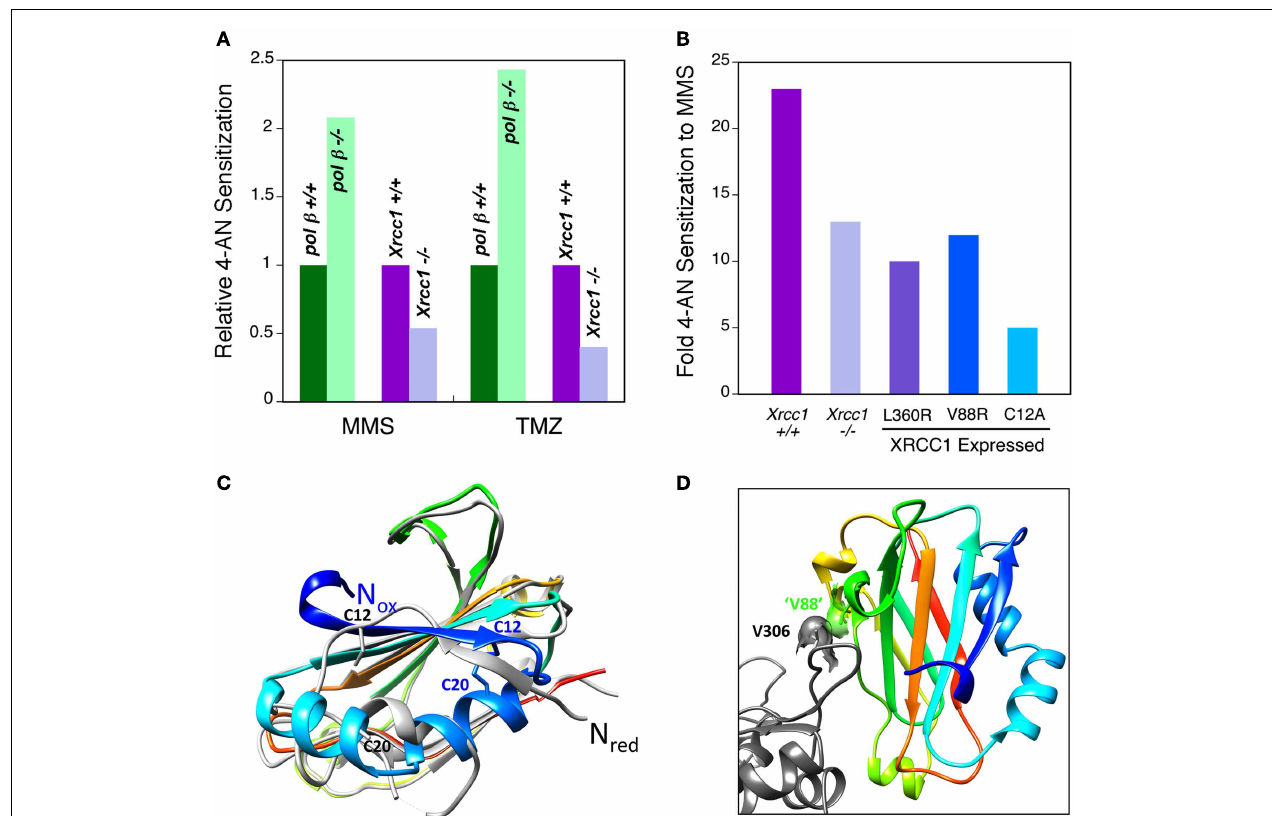
amino-termini are on opposite sides of this domain (N ox and N red , respectively). Accordingly, the interactions around the amino-termini are very different for these two forms.The cysteine residues (C12 and C20, respectively) that participate in disulfide bond formation in the oxidized form are indicated. (D) ‘V88’ (green) of mouse NTD forms a hydrophobic interaction withV306 (gray) of pol β .This portion of the pol β -binding interface is similar for both the oxidized and reduced forms of the NTD, and includes the hydrophobic interaction of XRCC1 ‘V88’ withV306 of pol β .V88 corresponds toV86 of the structurally characterized human NTD of XRCC1. Replacing this valine with arginine (V88R) significantly reduces the interaction between these proteins